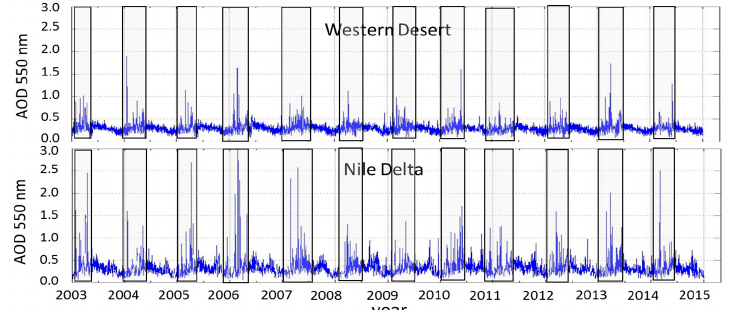
Figure 5. Daily time series of AOD at 550 nm from year 2003 to 2014 over the Western Desert (WD) and Nile Delta (ND) regions. Corresponding severe events are marked with the shaded boxes. Note that not all the events in the ND region originate in the WD region.